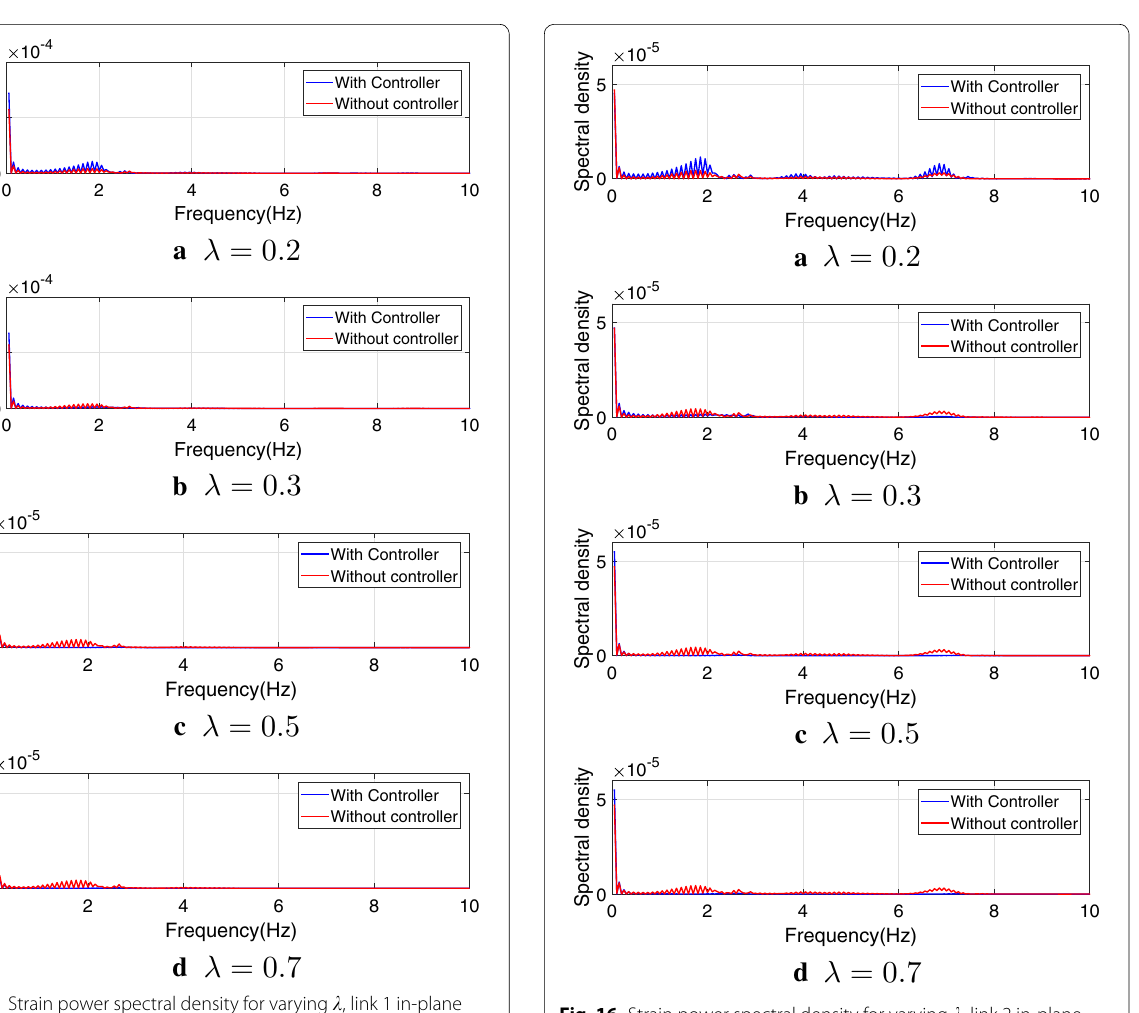
Fig. 16 Strain power spectral density for varying (cid:31) , link 2